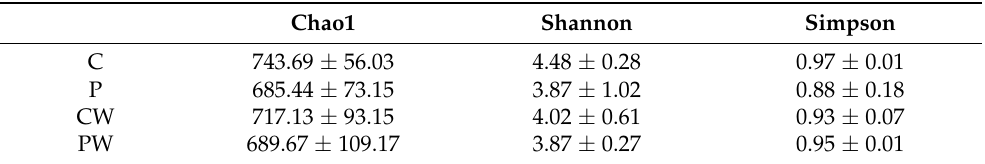
Table 1. Alpha diversity indexes of the microbiota associated with the skin mucosa of Sparus aurata . Fish feed with control diet without (C) and with wound (CW) and fish feed with probiotic diet without (P) and with wound (PW).